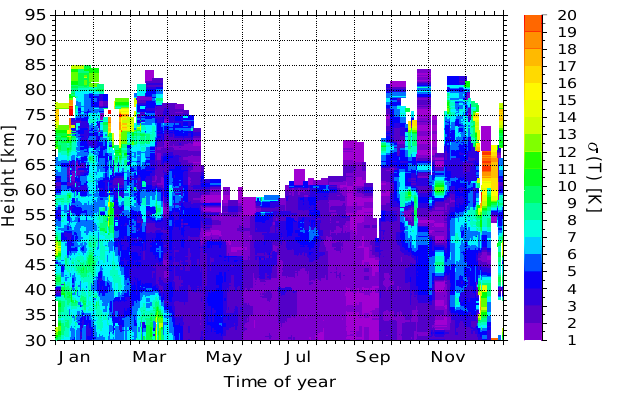
Fig. 6. Combination of the (smoothed) RMR lidar temperatures from Fig. 4 with the L¨ubken1999 climatology in the summer up- per mesosphere and the mean ECMWF temperatures interpolated to (70 ◦ N, 15 ◦ E) for 1997 to 2005 below 30km. The latter were smoothed with a 15-day running-average filter. The upper and lower limits of the RMR lidar data are marked by black lines. See text for details of the interpolation at the